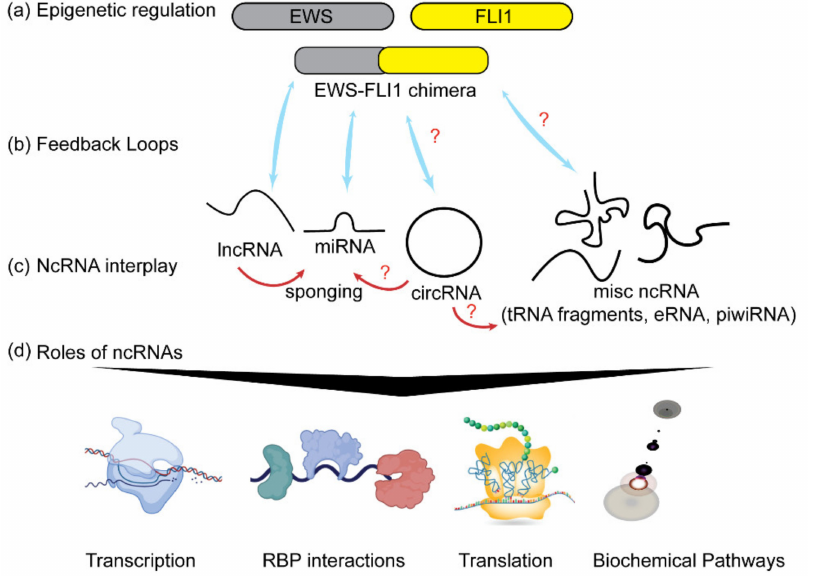
Figure 1. Noncoding RNAs and ES. ( a ) A chimeric fusion product of EWS and FLI1 genes, EWS- FLI1, exerts epigenetic control by regulating the expression of different classes of ncRNAs (shown as blue arrows). ( b ) Some ncRNAs also alter the expression of EWSFLI1 as a means of feedback regulation of their own expression levels. ( c ) ncRNAs have an extensive interplay between each other (shown as red arrows). ( d ) ncRNAs play roles in regulating transcription, RNA export and transport. They interact with different RNA binding proteins (RBPs), translation and modulating signaling pathways. Red question marks indicate unknown and yet to be explored